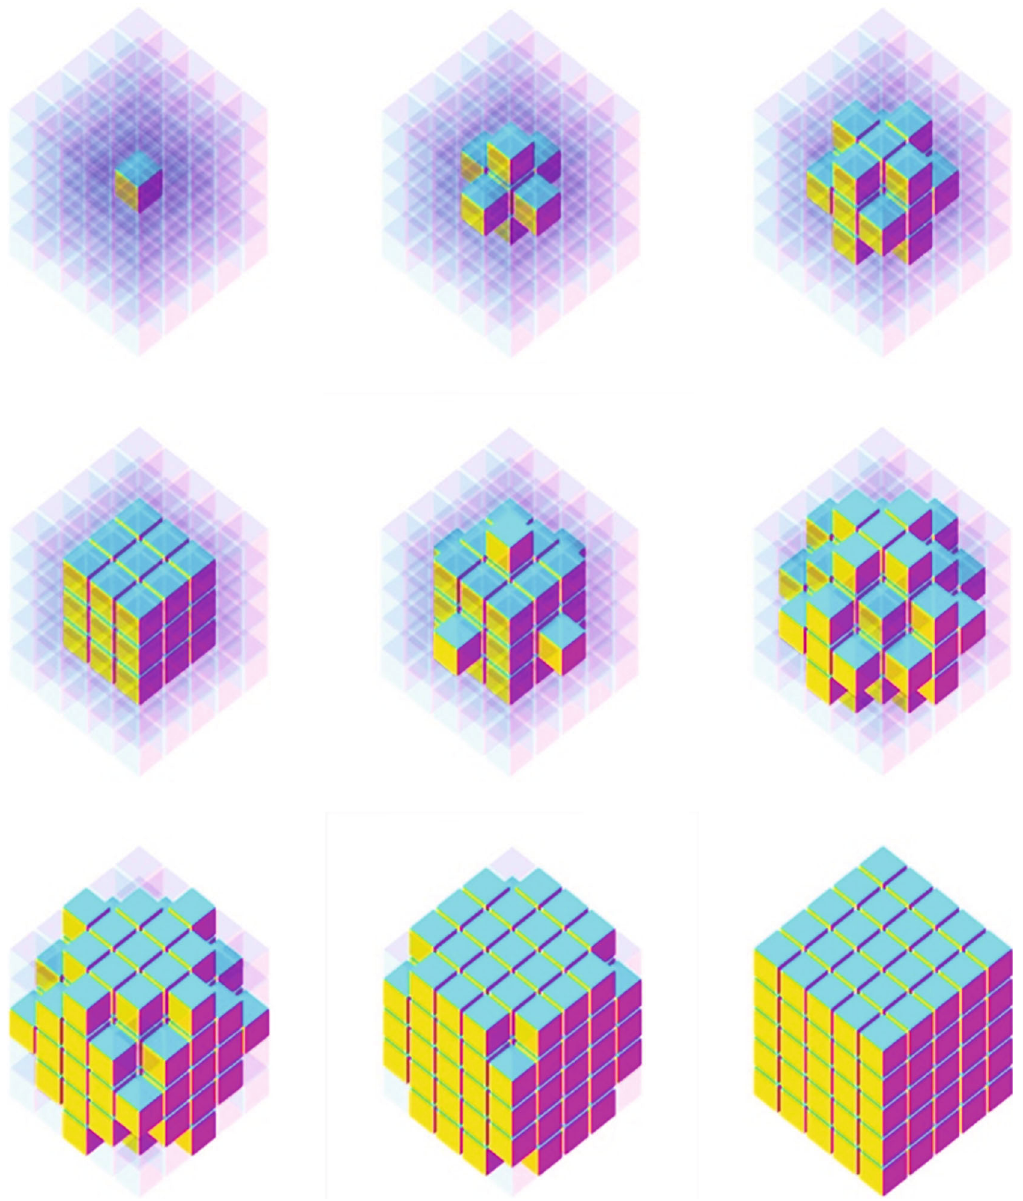
Figure 9: Stages of solving 5 × 5 × 5